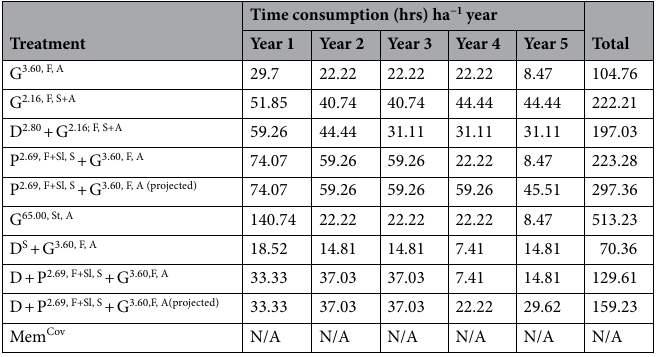
Table 3. Data inputs for time consumption per year for herbicide application (obtained from records from study system).